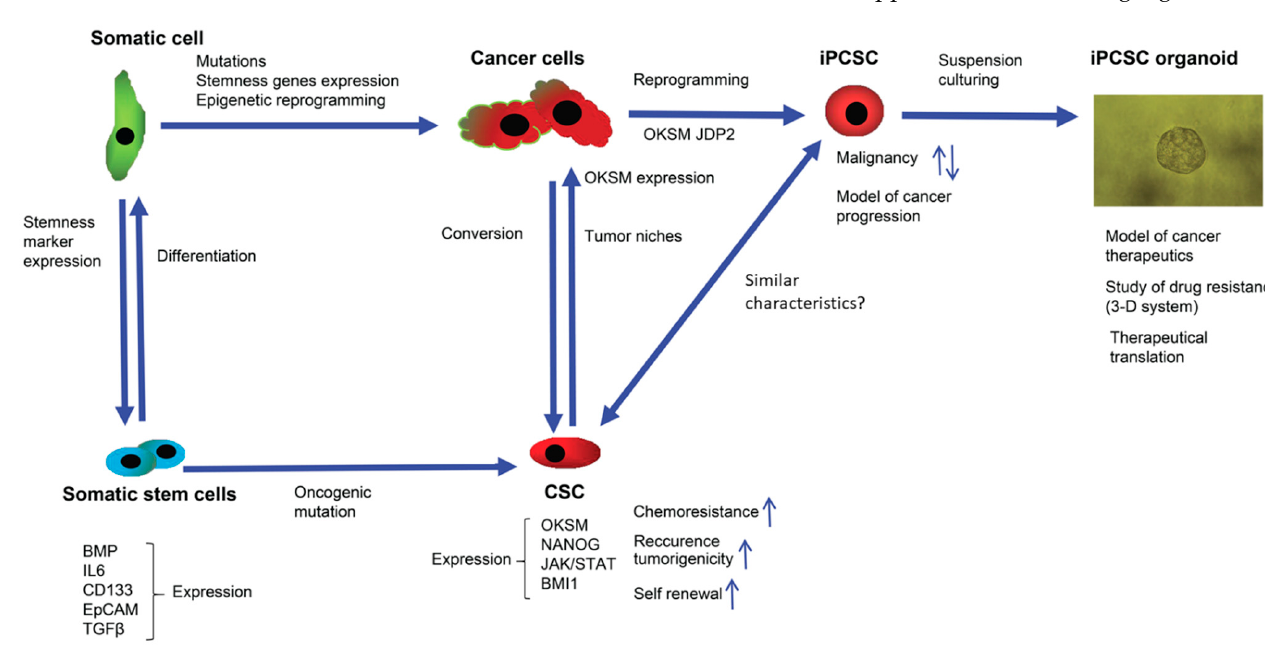
Figure 1. Cancer initiation and the process of cell stemness induction (reprogramming) employs overlapping molecular signaling and epigenetic pathways. Expression of transcription factors—such as OCT4, KLF4, SOX2, NANOG, and JDP2—is necessary for cancer initiation, along with genetic mutations and epigenetic changes. In somatic stem cells, for example MSCs, an increased expression of CD133 by the JAK-STAT 3 pathway activates the migration of MSCs to cancer cells and can increase the number of CSCs. CSC niche factors that induce self-renewal of CSCs stimulate angiogenesis and recruit other cells producing additional factors related to tumor metastasis. Patient-derived iPCSC organoid models are useful for examining the mechanisms of drug resistance and cancer progression.